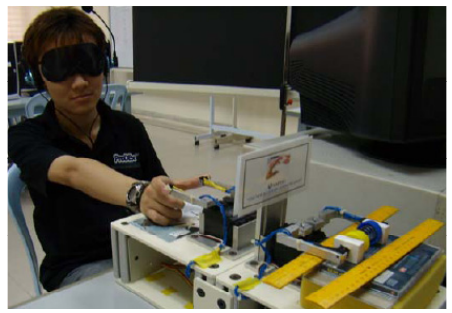
Fig. 3. One of the users comparing the relative hardness of the test objects through the master-slave haptic gripper